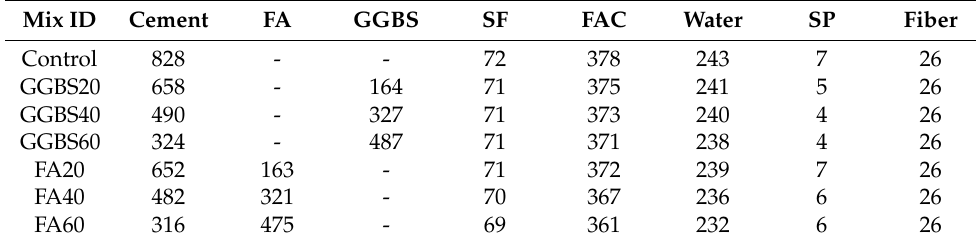
Table 4. Mix proportion of ULHS-ECCs, kg/m 3